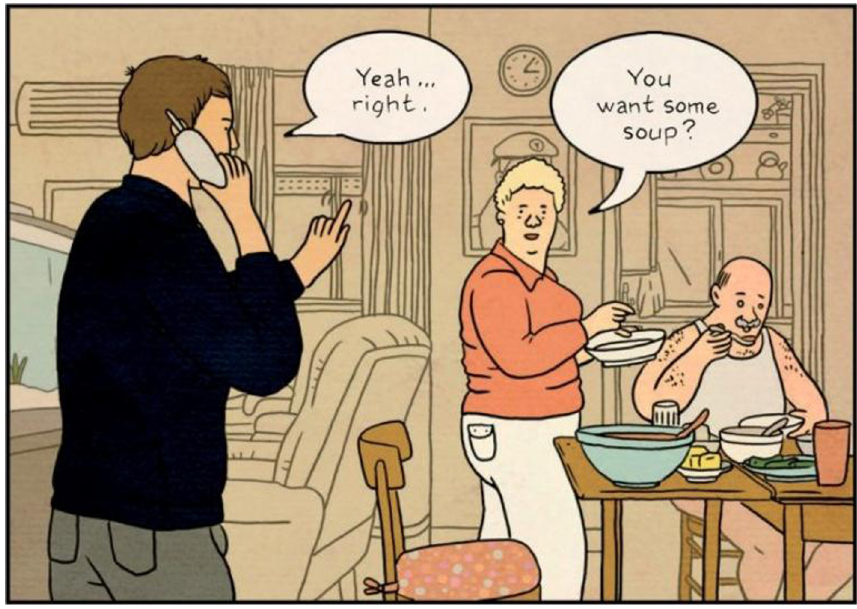
Figure 2: Obscured Representations of Trauma in Exit Wounds by Rutu Modan, 2007: 22. © 2007 Drawn & Quarterly – Rutu